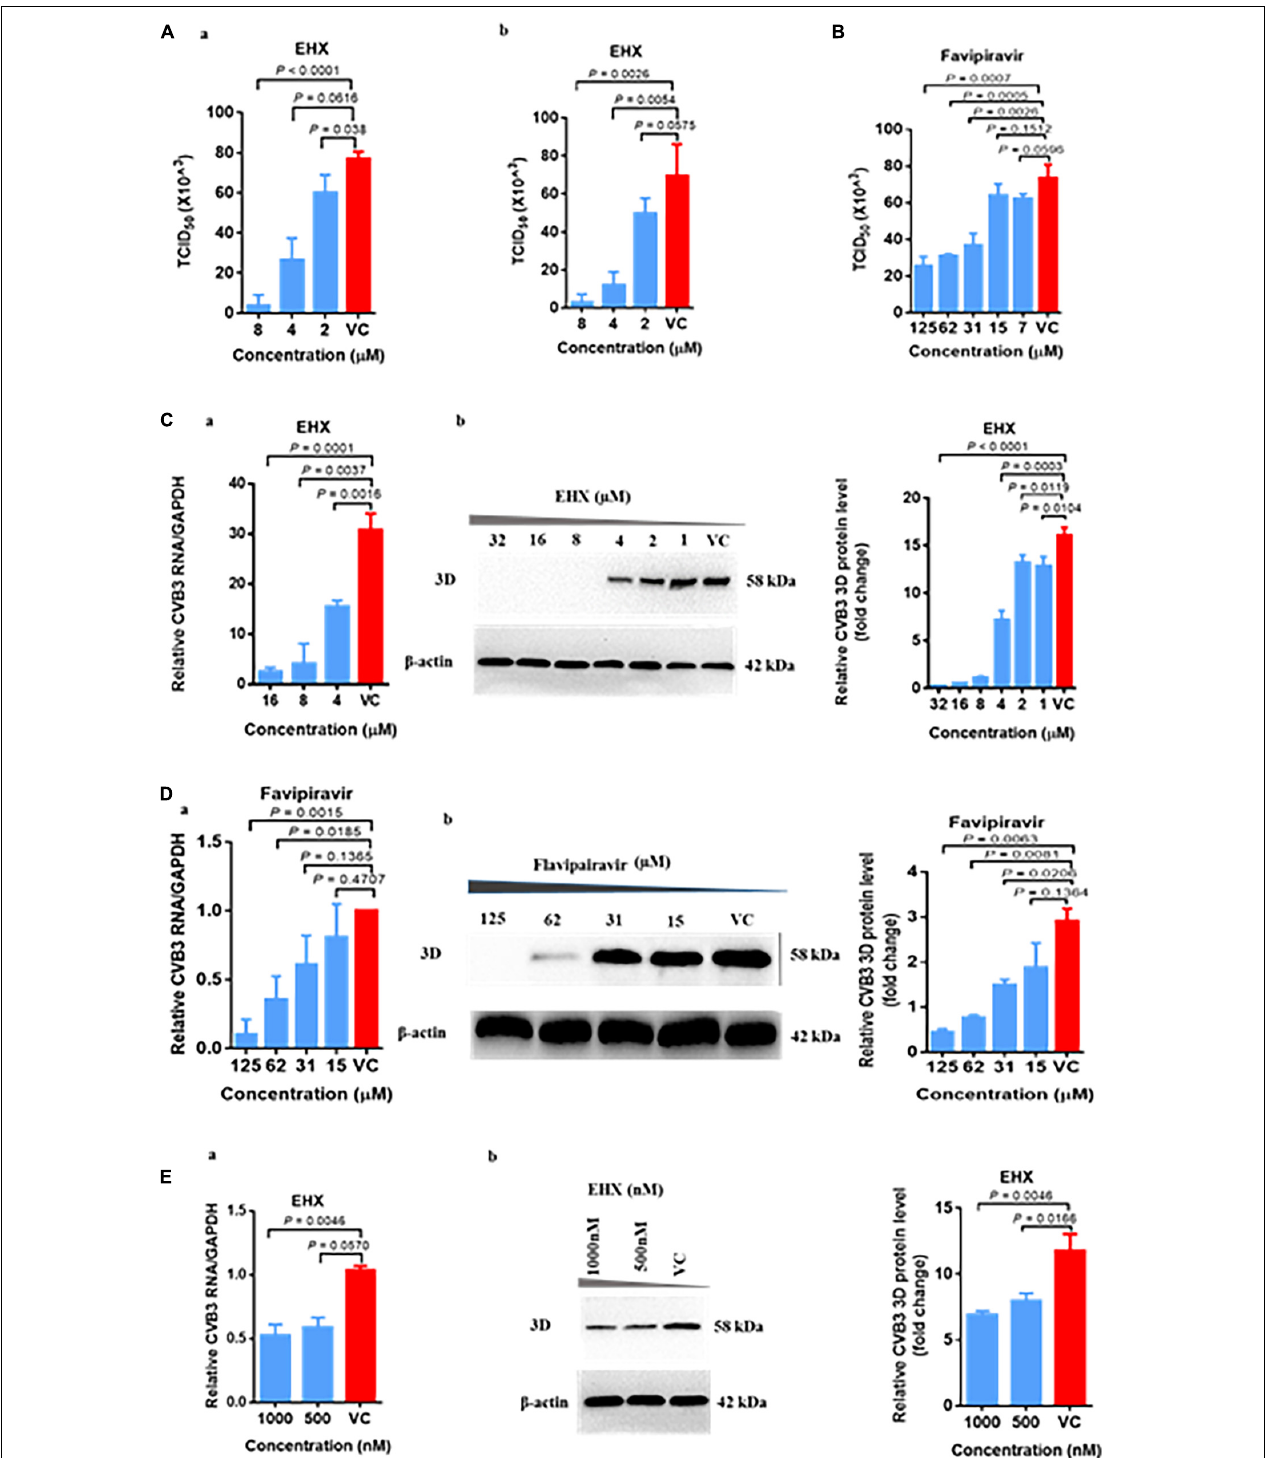
FIGURE 2 | EHX effectively inhibits CVB replication in vitro . HeLa cells were infected with CVB3 (MOI = 1) for 24 h. (A) EHX inhibits virus-yield. CVB3-infected cells were treated with EHX at the indicated concentrations. (a) Cells were subjected to three freeze-thaw cycles; (b) culture supernatant were collected and quantified for CVB3 by median tissue culture infectious dose (TCID 50 ) assay. (B) Favipiravir inhibits virus yield. CVB3-infected cells were treated with favipiravir at the indicated concentrations. Cell culture supernatant were collected and quantified using the TCID 50 assay. (C) EHX inhibits the viral RNA and 3D protein level.